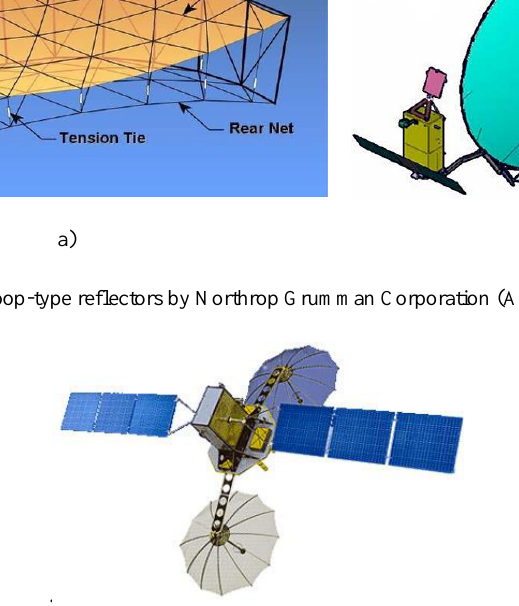
. Fig. 3. Reflectors with diameter of 4.5 m at Luch 5A